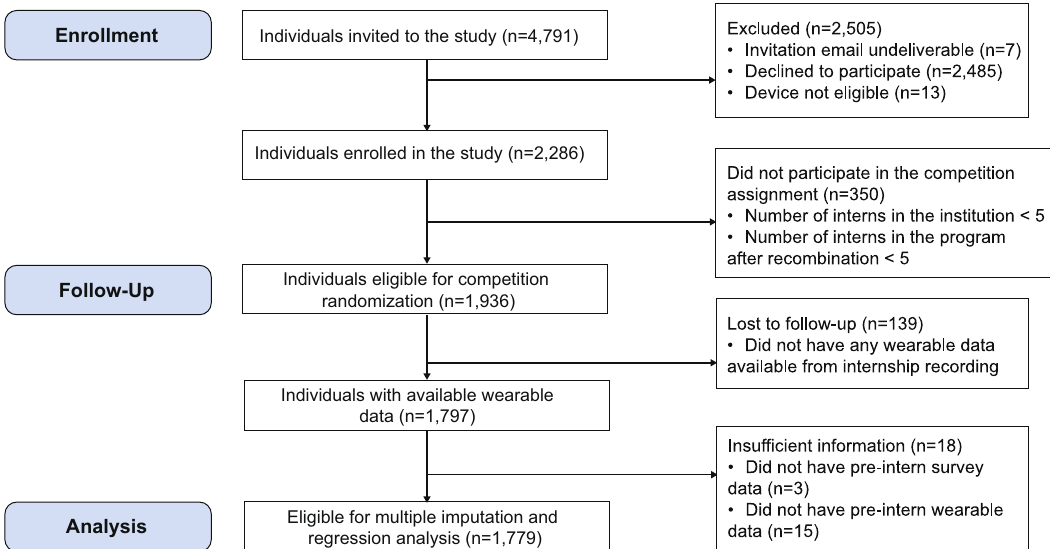
Fig. 1 Study fl ow diagram. Flow diagram detailing the number of subjects who were enrolled, participated, randomized, and analyzed in the study.